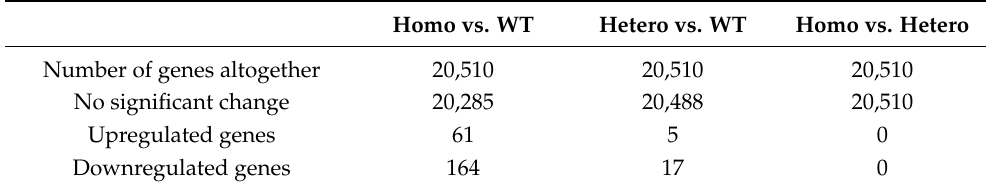
Differential gene expression detected with a false discovery rate (FDR)-corrected p -value <